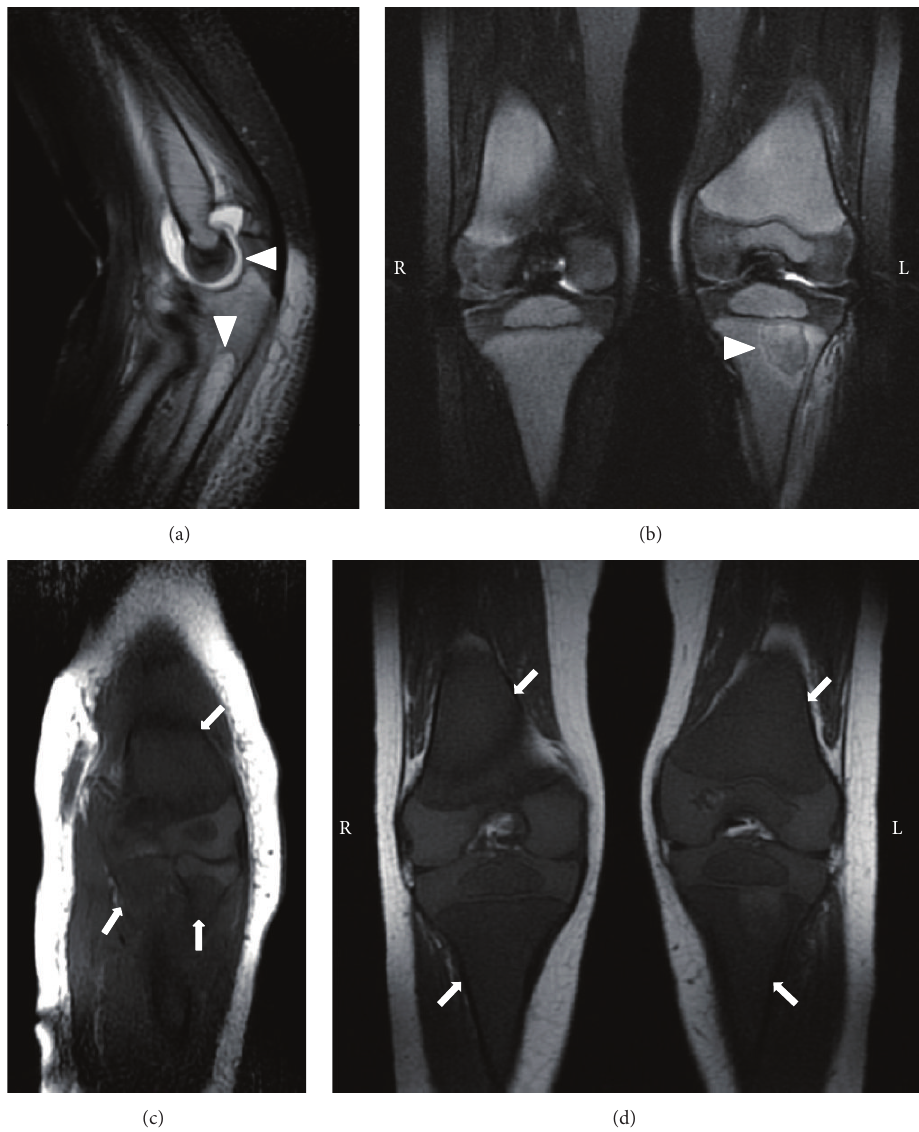
Figure 4: MRI findings in case 4. At 6 days after the disease onset, (a) T2-weighted image shows accumulation of synovial fluid and high signal intensity in the ulnar bone marrow (arrowheads) and (c) T1-weighted images depict diffuse low signal intensity in the left humeral, radial, and ulnar bone marrow (arrows). At 18 days after the onset, (b) T2-weighted image reveals local high signal intensity in the left tibial bone marrow (arrowhead) and (d) T1-weighted image depicts diffuse low signal intensity in the bilateral femoral and tibial bone marrow